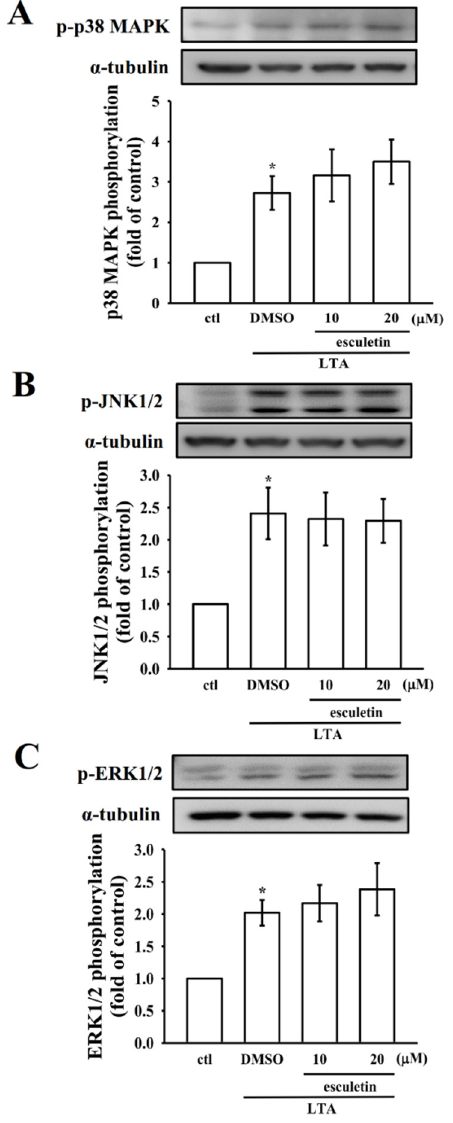
Figure 3. Influence of esculetin on LTA-induced phosphorylation of p38 mitogen-activated protein kinase (p38 MAPK), c-Jun NH2-terminal kinase (JNK), and extracellular signal-regulated kinase (ERK) in RAW cells. ( A–C ) Cells were treated with 0.1% Dimethyl sulfoxide (DMSO) or esculetin (10 and 20 µM) for 1 h, followed by LTA (10 µg/mL) for 1 h, and the phosphorylation of ( A ) p38 MAPK, ( B ) JNK1/2, and ( C ) ERK1/2 were evaluated by immunoblotting assay as described in the Methods section. Data are presented as the means ± SEM ( n = 4). * p < 0.05, compared with the control group.